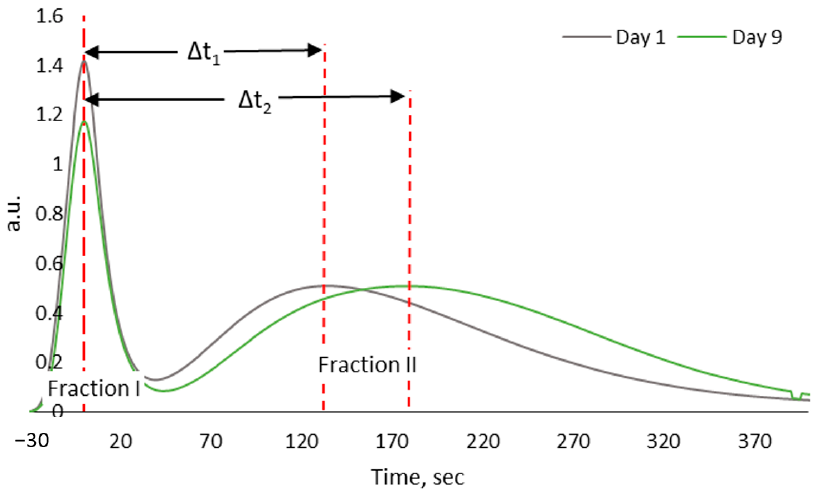
Figure 3. Comparison of two FPMLC chromatograms obtained on days 1 and 9 of a horse meat sample storage.